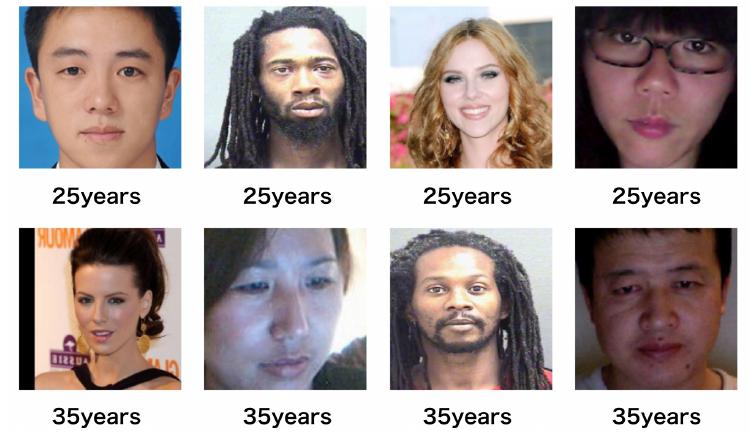
Figure 1. Differences between different people of the same age.